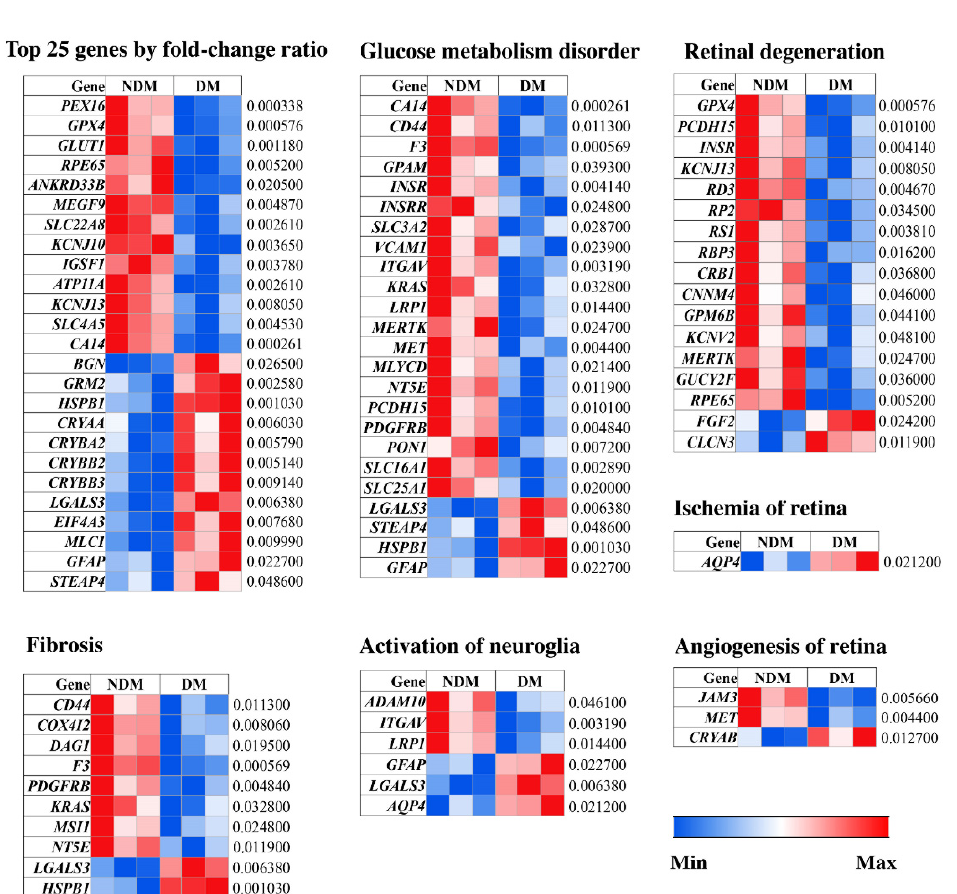
Figure 5. General and pathophysiology-specific heat maps of significantly altered MAM proteins in Type 1 diabetic rat retinas. MAM proteins that were most affected by fold-change ratio were selected among the 179 altered MAM proteins in the Type 1 diabetic condition. Proteins with a p -value of less than 0.05 were considered significant. p -values for each altered protein are shown on the right of each map. NDM: non-diabetes mellitus, DM: diabetes mellitus, MAM: Mitochondria-associated ER membrane.